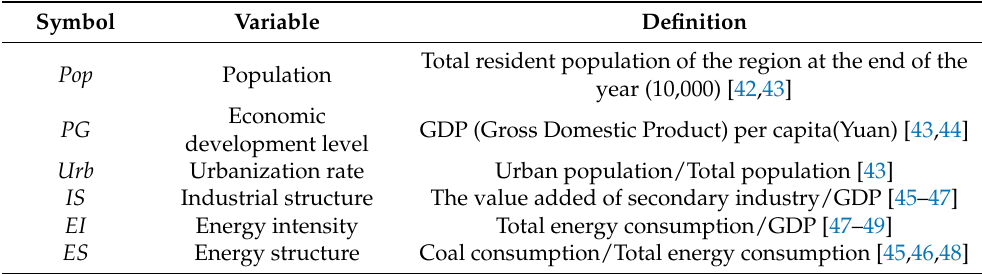
Table 1. Definition of carbon emission influencing factors and indicators. Symbol Variable